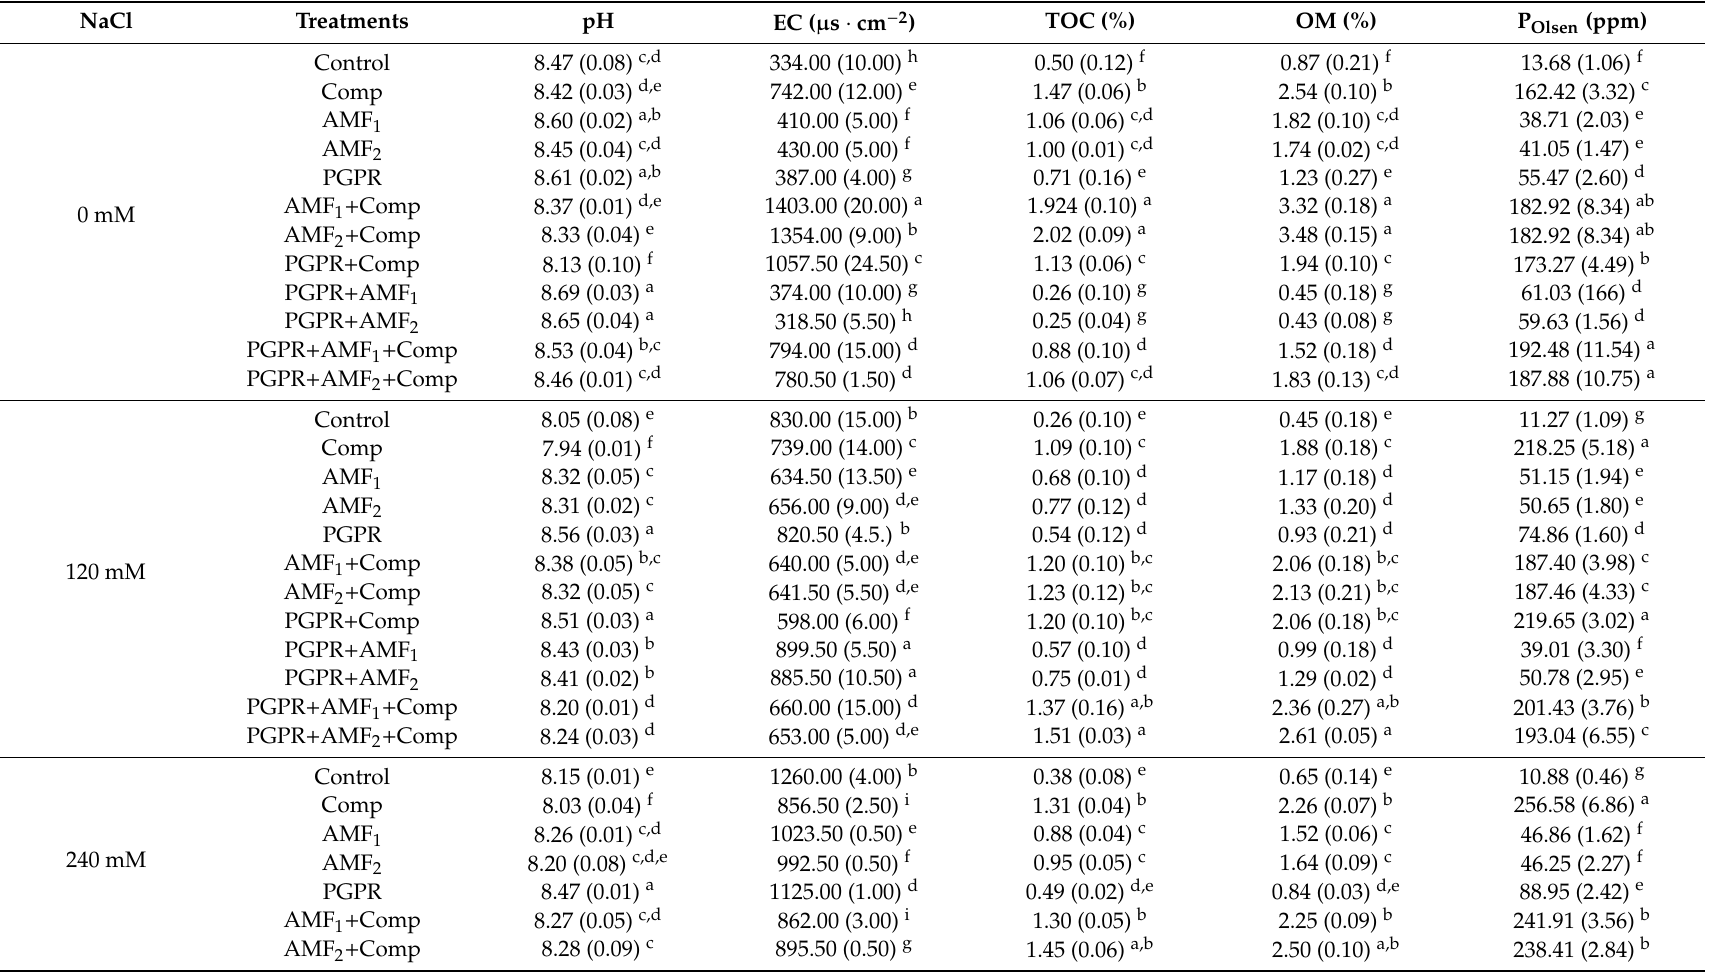
Table 5. E ff ects of biofertilizers on soil physicochemical properties after harvesting the date palm